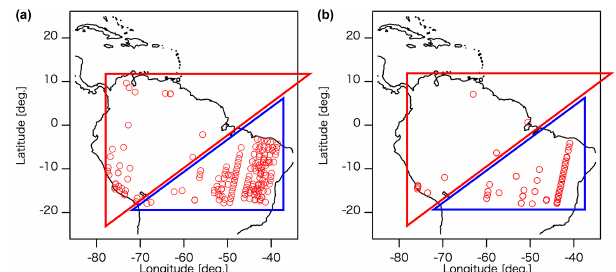
Figure 14. Clear-sky data with (a) and without (b) dithering ob- servation over the Amazon in September 2014. Upper and lower triangles are categorized as tropical rain forest and Cerrado, respec- tively. The repeated observation location are